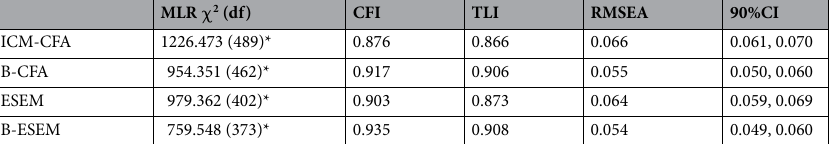
Table 3. Goodness-of-fit statistics of the alternative measurement models. ICM, Independent cluster model; CFA, Confirmatory factor analysis; B, Bifactor model; ESEM, Exploratory structural equation modelling; MLR, Maximum likelihood with robust standard errors; χ 2 , MLR chi square; df, Degrees of freedom; CFI, comparative fit index; TLI, Tucker-Lewis index; RMSEA, Root mean square error of approximation; CI, Confidence interval. *p <